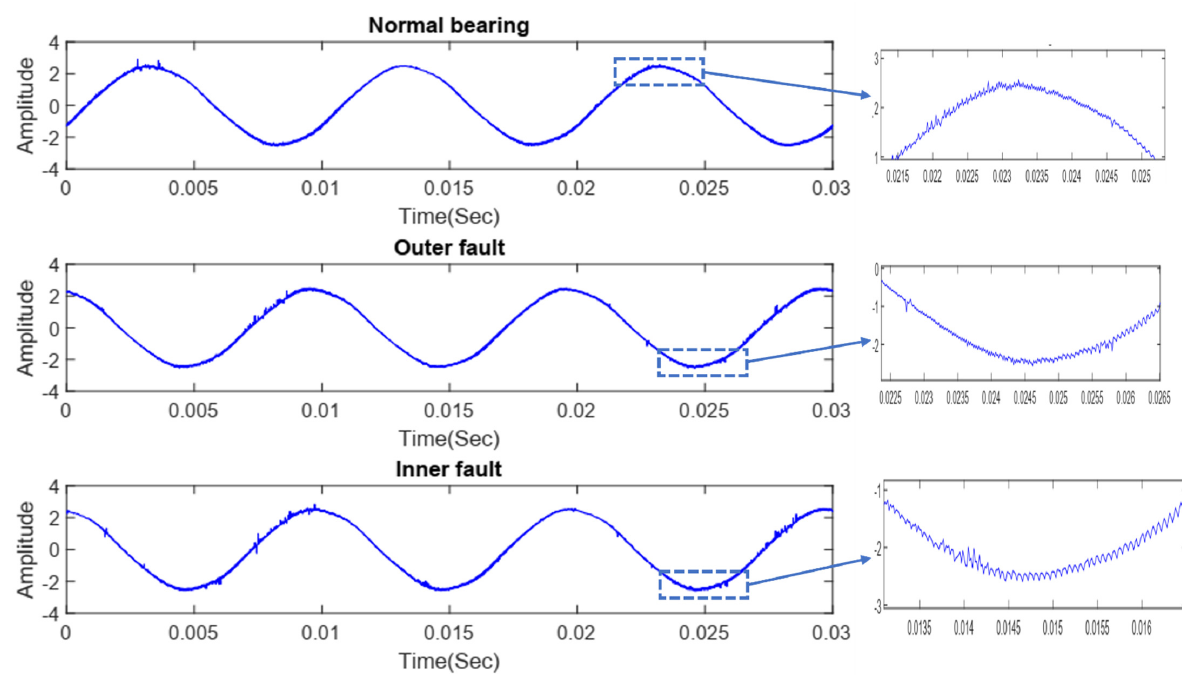
Figure 4. Time − domain signal of the different bearing conditions.